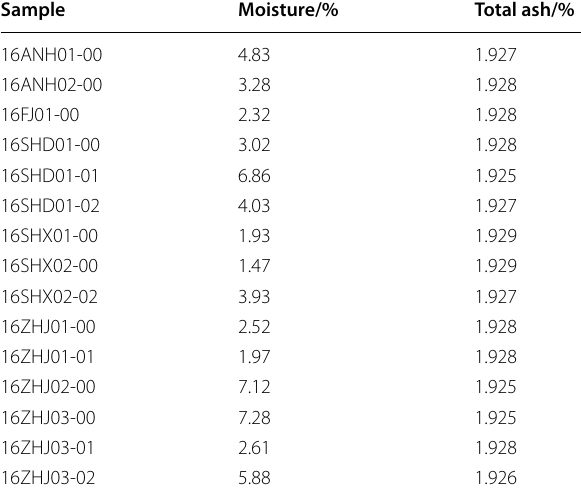
Table 2 The results of water soluble and alcohol soluble extract